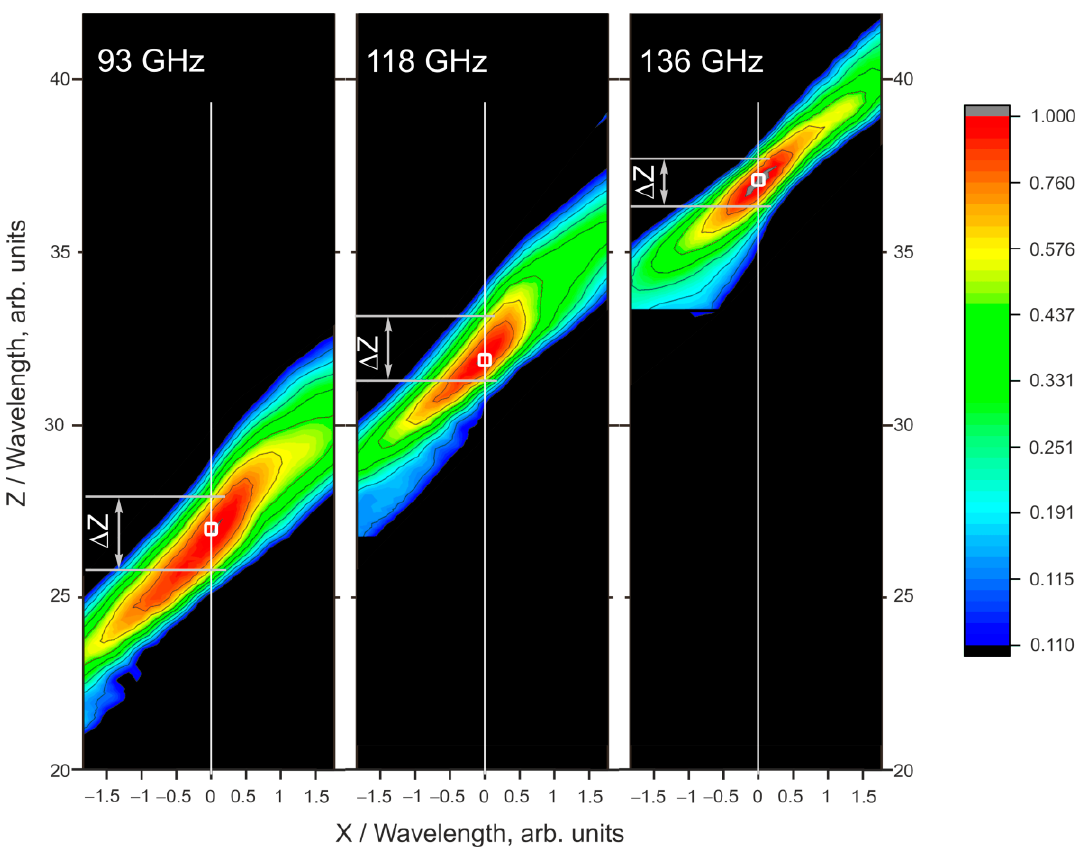
Figure 3. MM intensity distribution in ZX plane at the frequencies 93 ( left ), 118 ( middle ), and 136 ( right ) GHz. X and Z coordinates are normalized to the radiation wavelength. Open squares show the boundaries of the photosensitive area of the pyroelectric receiver. The full width at half-maximum (FWHM) of intensity distribution along the Z -axis is shown as ∆ Z.